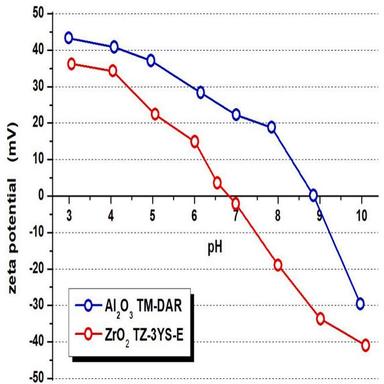
Zeta potential curves in the pH function for pure Al2O3 and ZrO2.